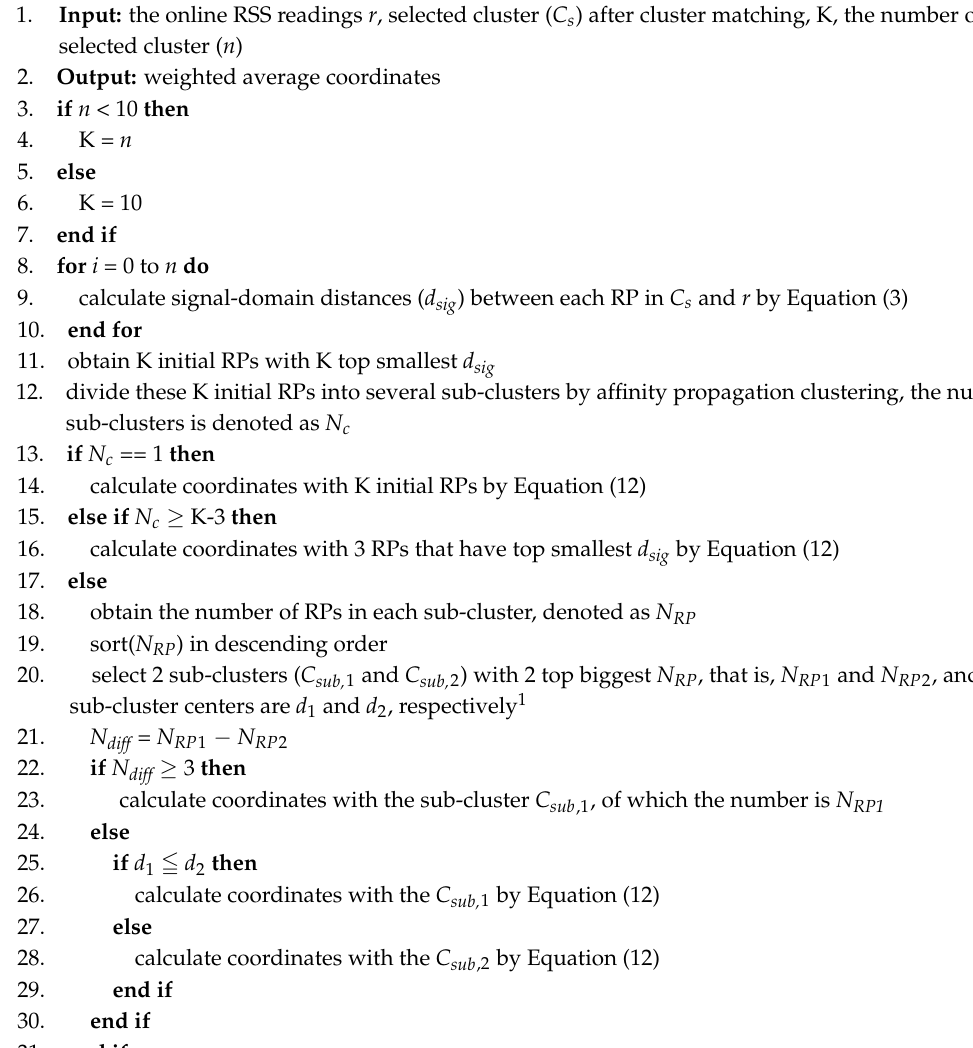
Algorithm 2: The proposed AWKNN localization